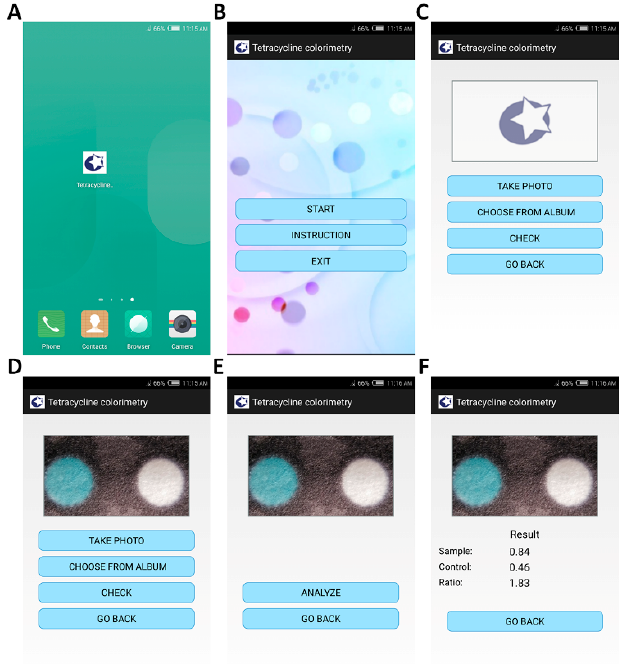
Figure 3. Smartphone application tetracycline colorimetry. ( A ) Application icon on the smartphone desktop. ( B ) Initial interface of the application. ( C ) Inkjet printing paper chip image input. ( D ) Image quality check. ( E ) Image analysis. ( F ) Test to control intensity ratio in red channel extraction.